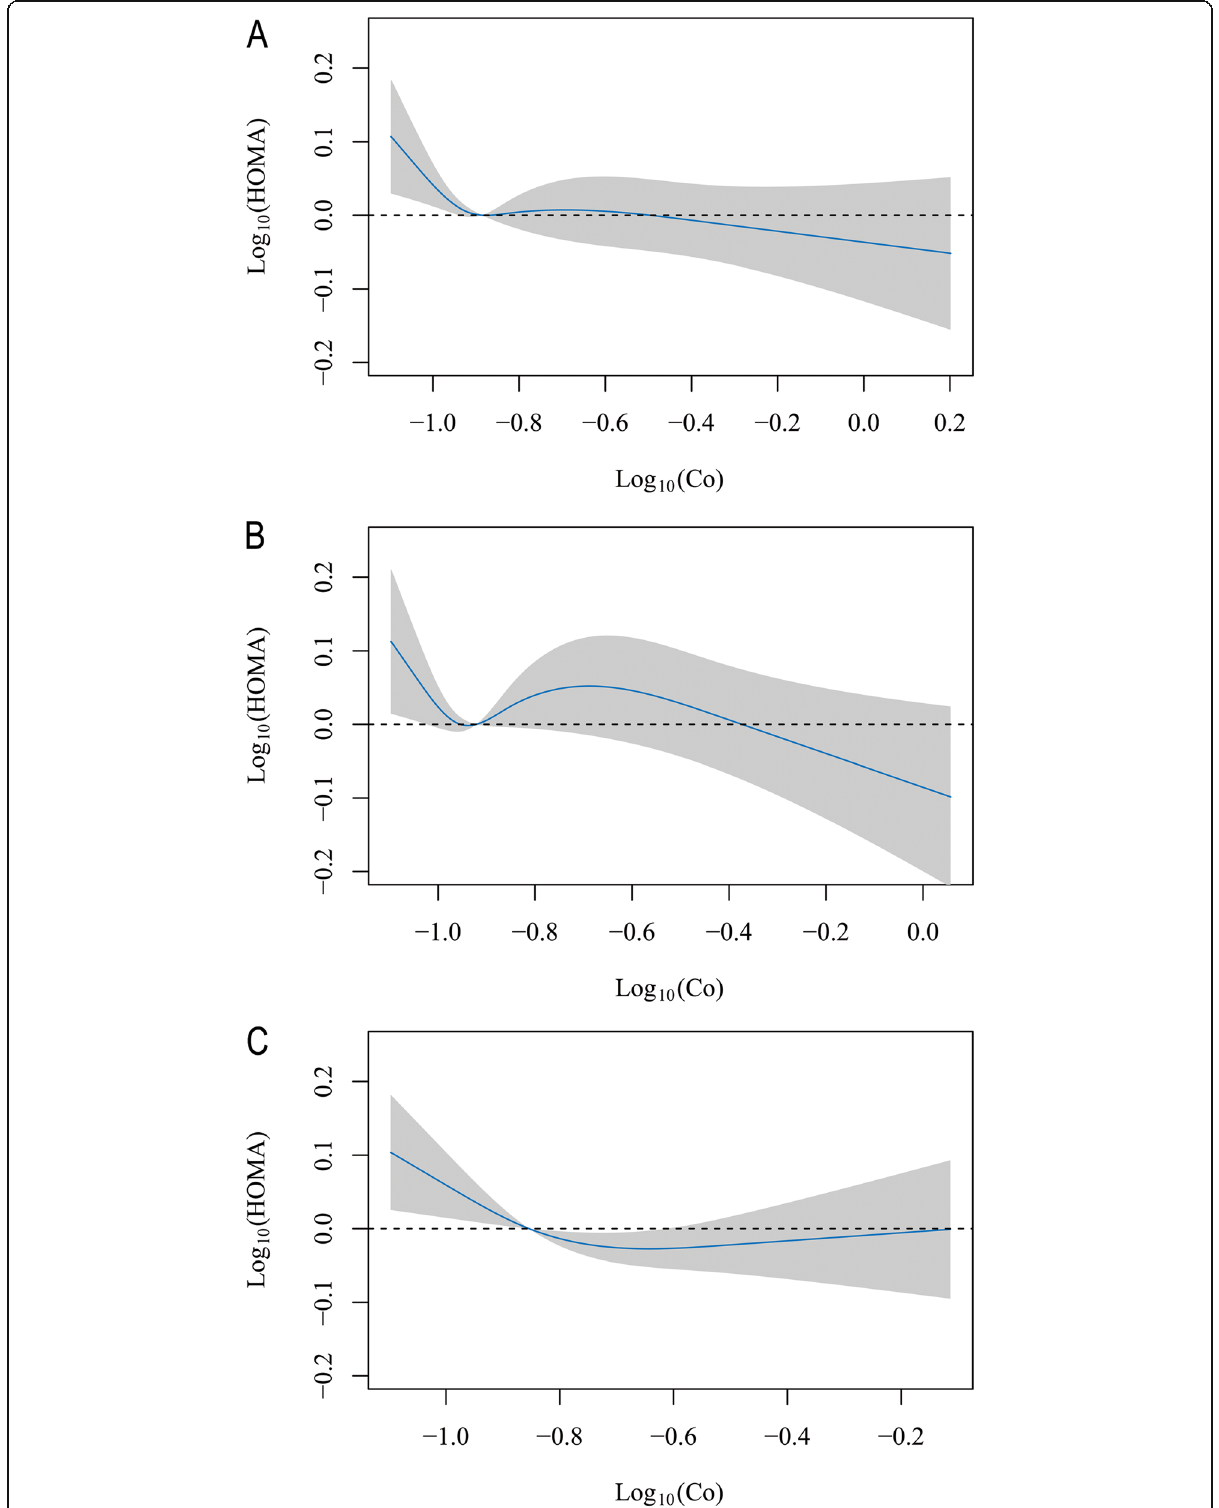
Fig. 4 Predicted spline curves for the associations of HOMA-IR with blood Co concentrations according to restricted cubic spline regression models in the overall population ( a ), in males ( b ) and in females ( c